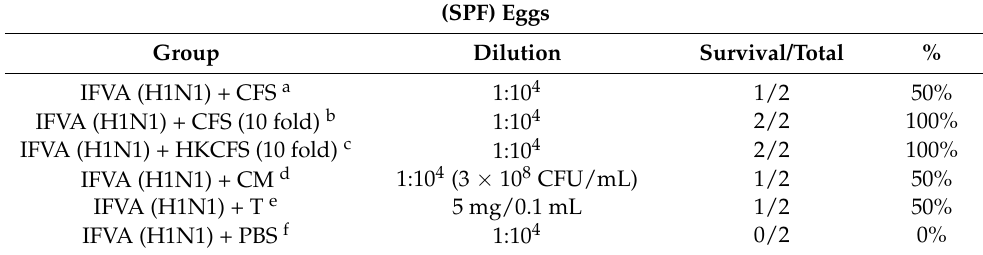
Table 6. In ovo antiviral activity of L. plantarum YML015 on embryo eggs. Antiviral Activity of Lactobacillus plantarum YML015 Using Specific